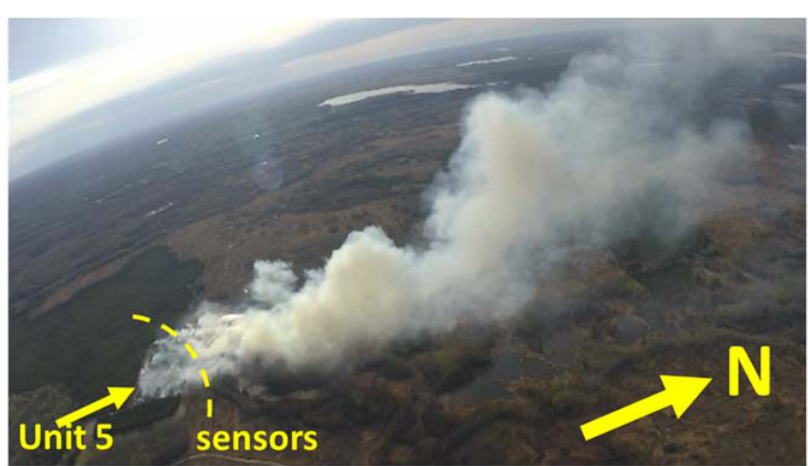
Figure A2. Aerial picture of smoldering smoke propagating in north-northeast direction, taken at 18:31 local time. Sensor deployment locations at ~500 m from the fire area (unit 5) are shown by the dashed line. Mostly horizontal propagation of smoke confined to ground level, especially in the near-field range can be observed.